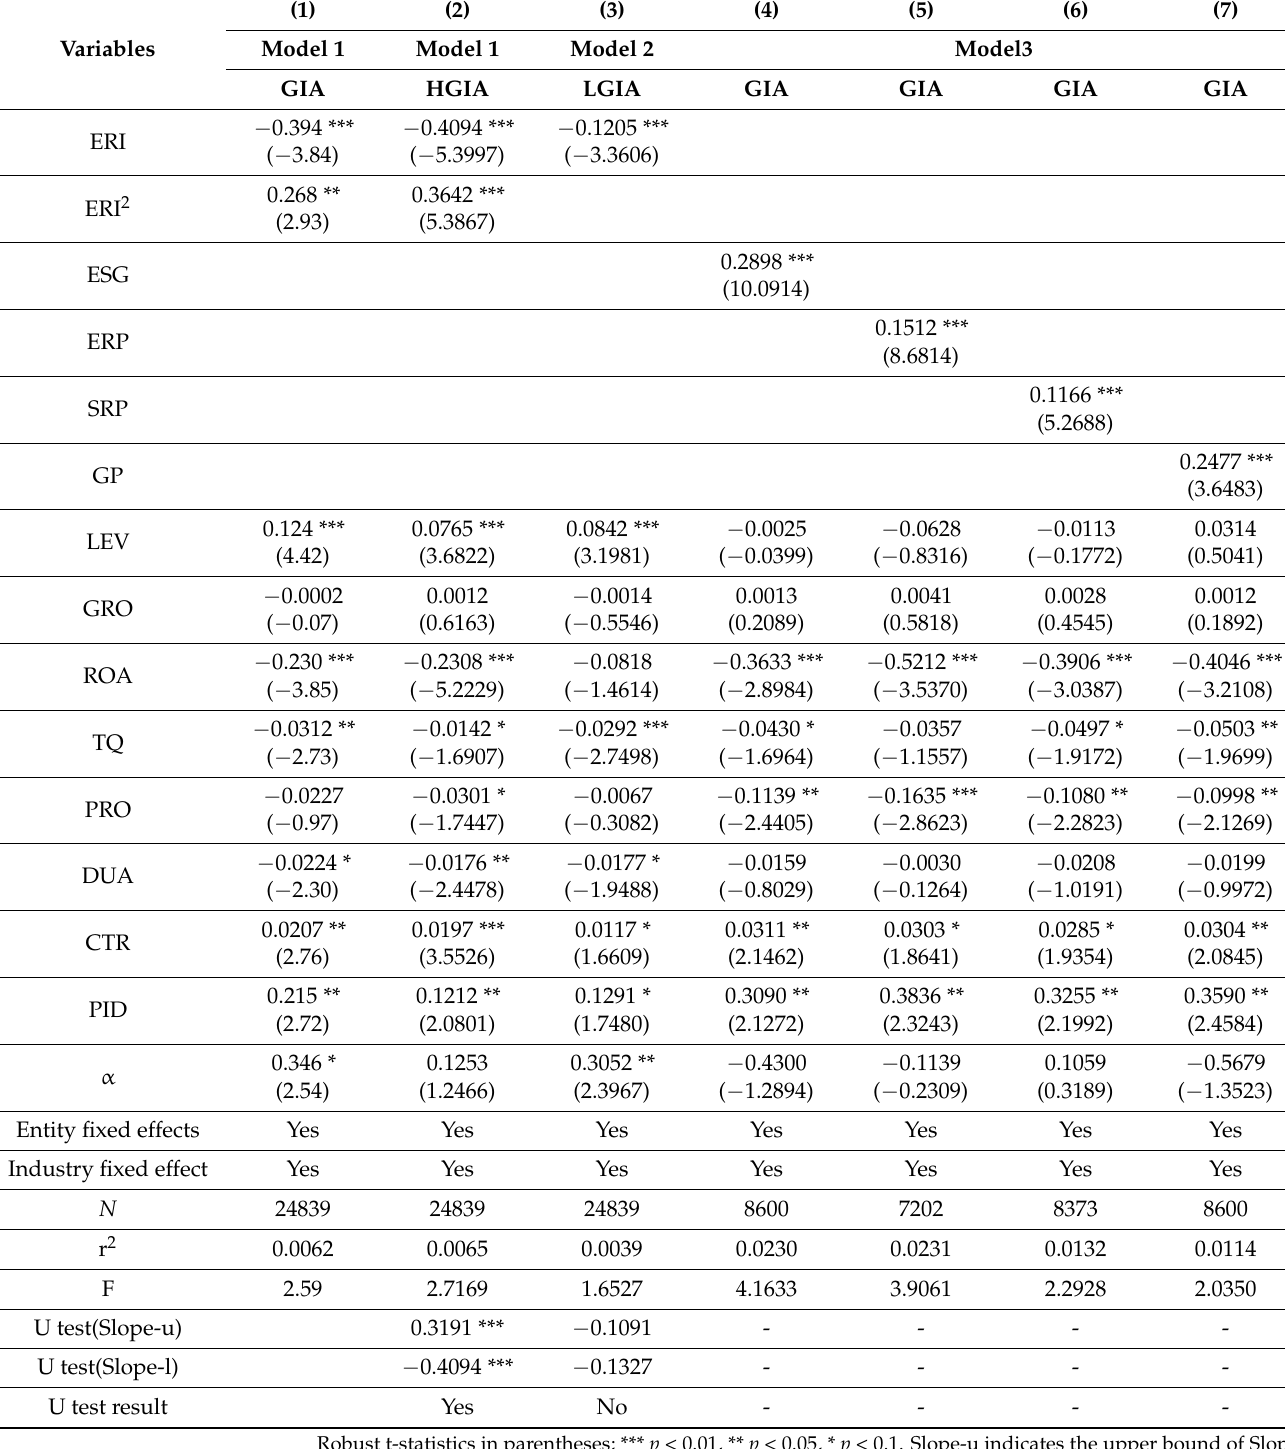
Table 4. Empirical results of the impact of ESG on corporate green